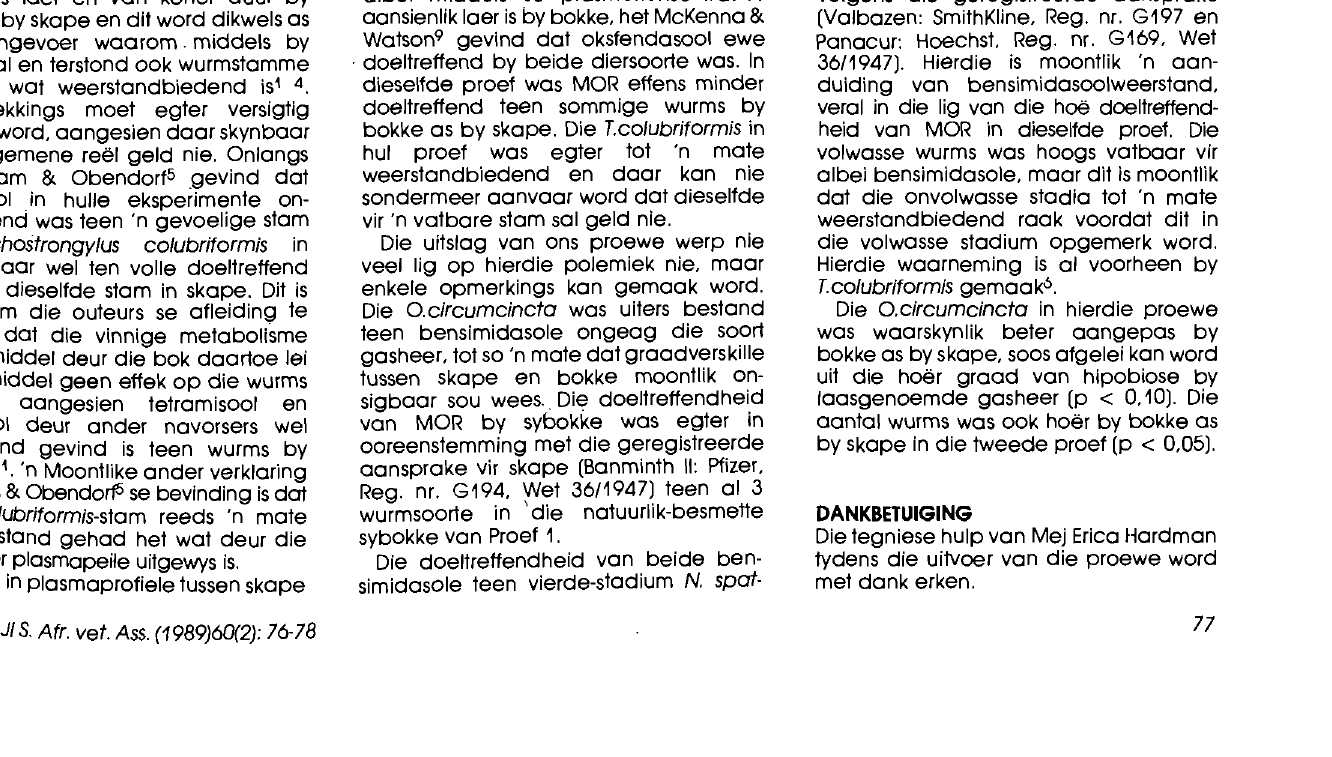
Tabel 2: Gemlddelde O.circumcincta·tellings en persentasie doeltreffendheld van behandeling met albendasool in skape en